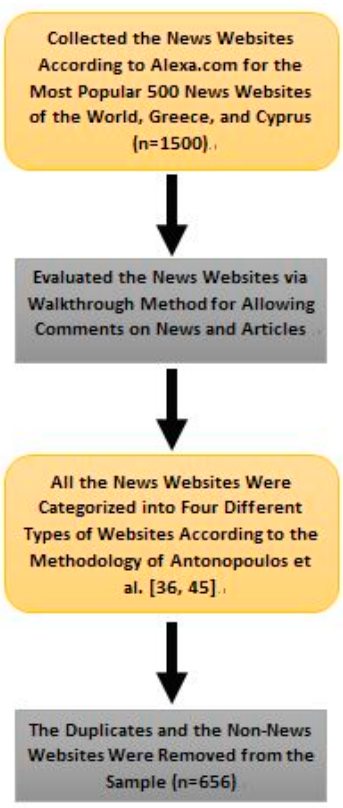
Figure 1. The summary of the methodology.